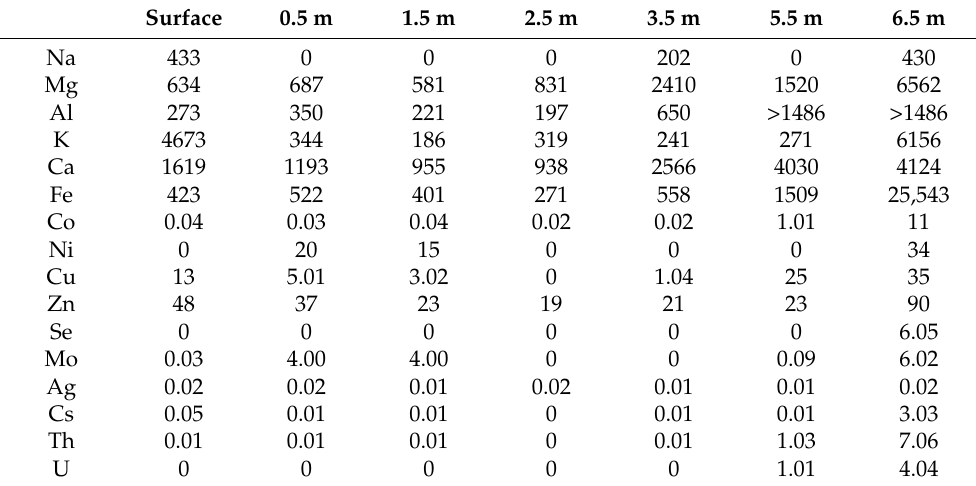
Table 3. Metal concentrations from the microwave assistant extraction of Lastensuo bog surface moss, peat, gyttja, and clay layers (mg/kg